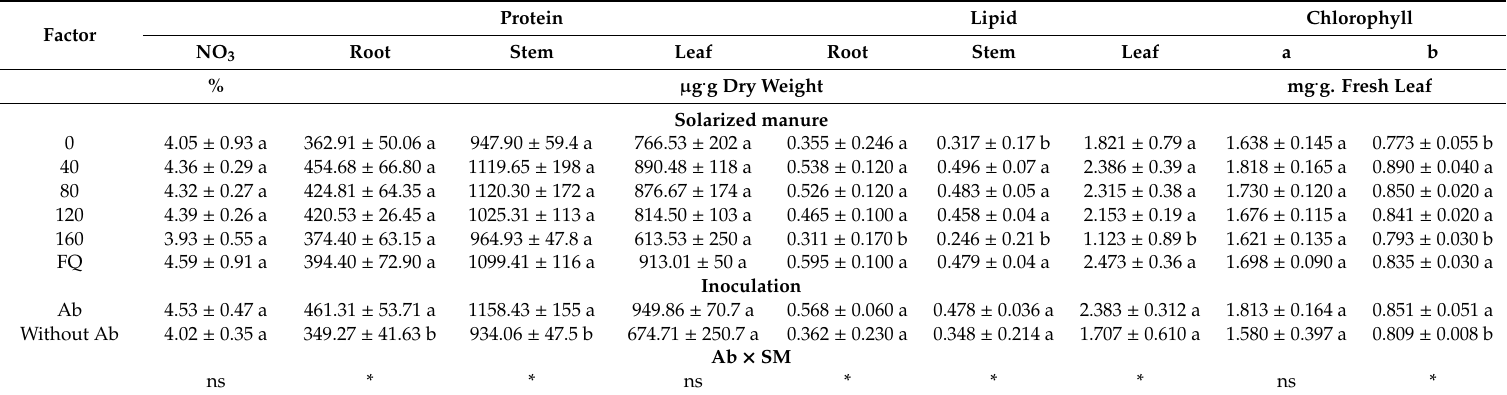
Table 4. E ff ect of Azospirillum brasilense (Ab), solarized manure and interaction (Ab × SM) on percentage of nitrates (NO 3 ), protein and lipids ( µ g.g dry weight) in the root, stem and leaf and chlorophyll (a, b) in tomato plants in the flowering